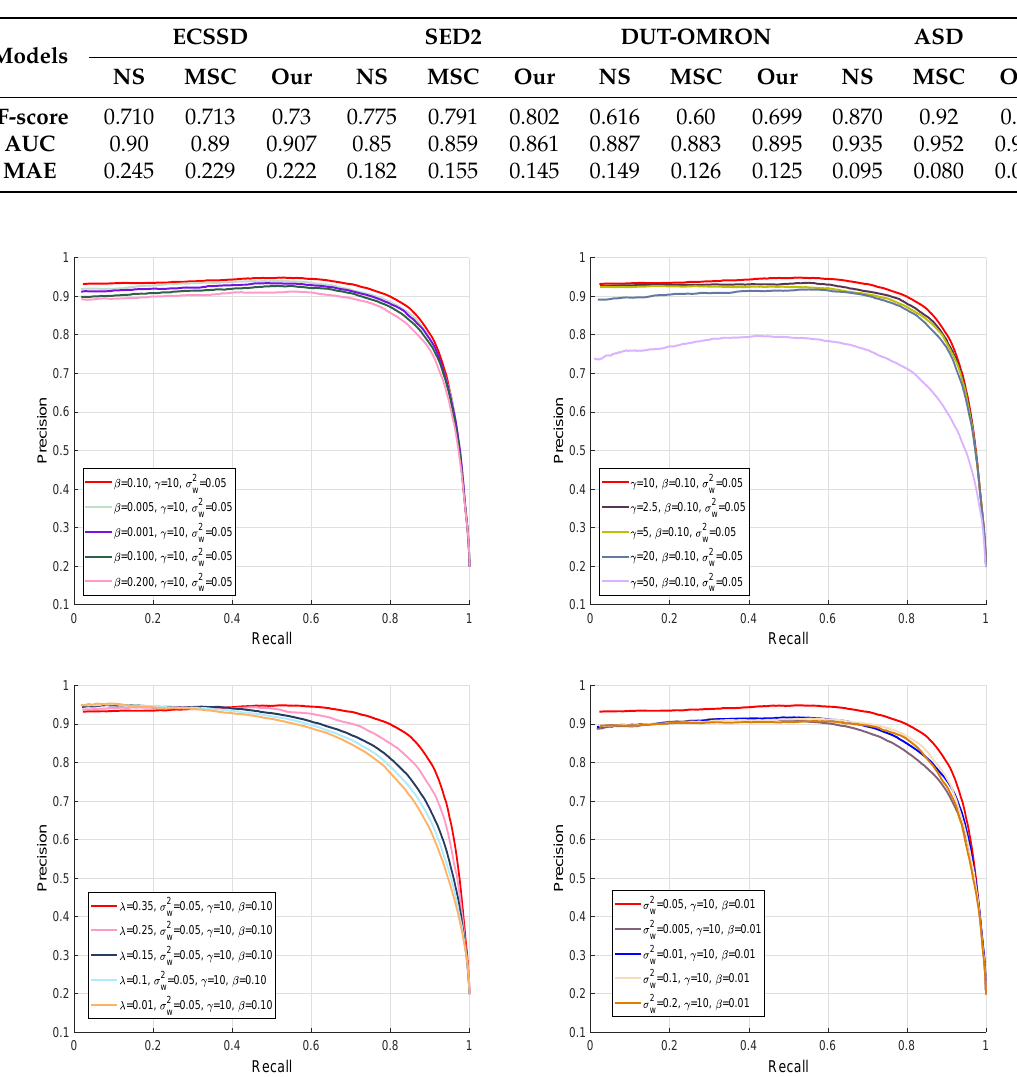
Figure 8. PR-curves to validate our proposed method with different parameters values for the MSRA database. The balancing parameter is tuned at different values to verify the refinement function and their effect on the final SRD